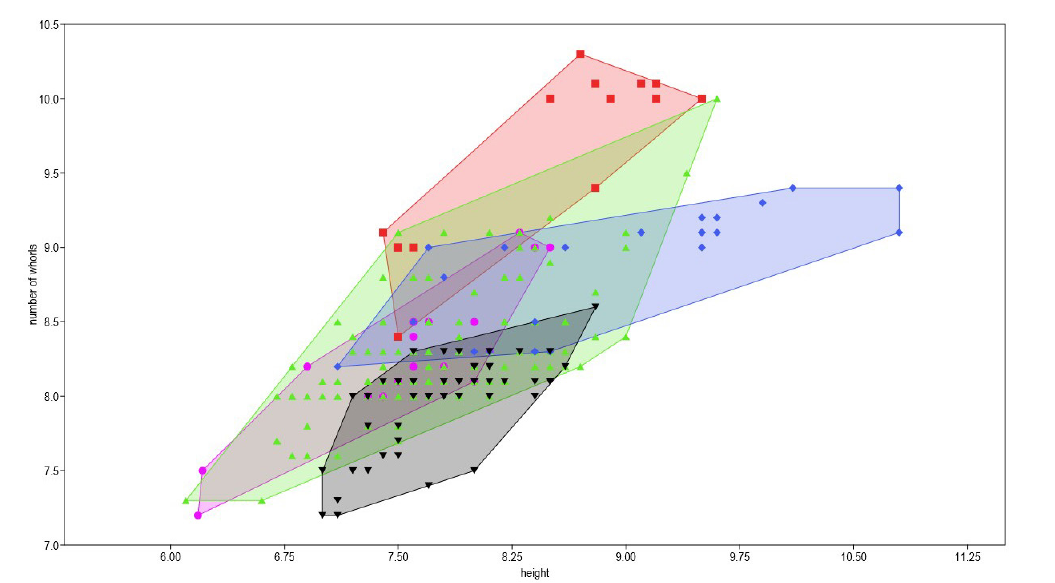
Fig. 9. Number of whorls vs height of the species in Clessiniella Zallot et al ., 2015. Violet dots = Cochlostoma ( Clessiniella ) anomphale Boeckel, 1939; red squares = Co. ( Cl. ) stelucarum sp. nov.; green triangles = Co. (Cl.) tergestinum (Westerlund, 1878); blue diamonds = Co. ( Cl. ) villae (Strobel, 1851); black triangles = Co. ( Cl. ) waldemari (A.J. Wagner, 1897). Analysis performed with the software ‘Past’ (https://palaeo-electronica.org).